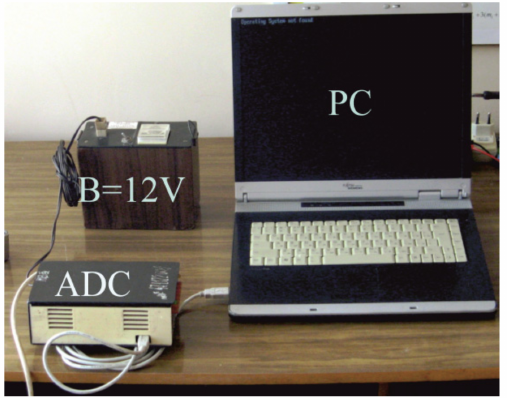
Figure 6. Measuring and recording